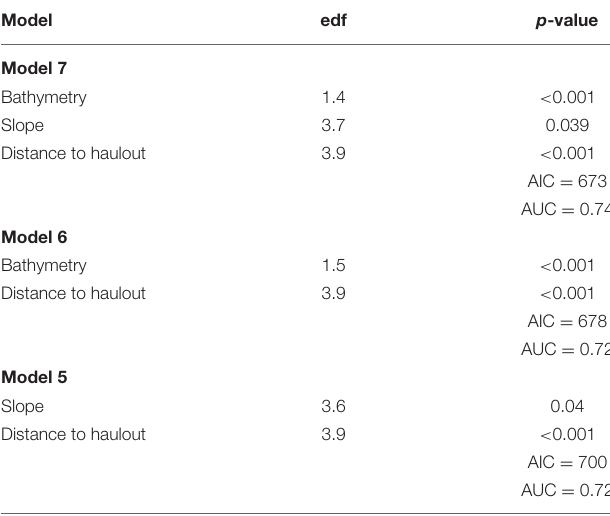
TABLE 3 | Top three candidate model summaries estimated by generalized additive models predicting probability of predation including Akaike Information Criterion ( AIC ) and area under the curve (AUC)